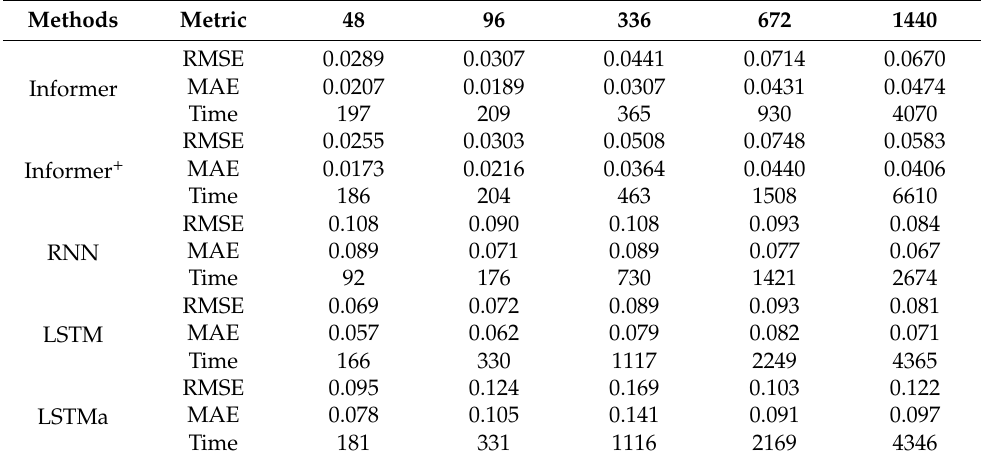
Table 5. Performance of different models in power-load forecasting.